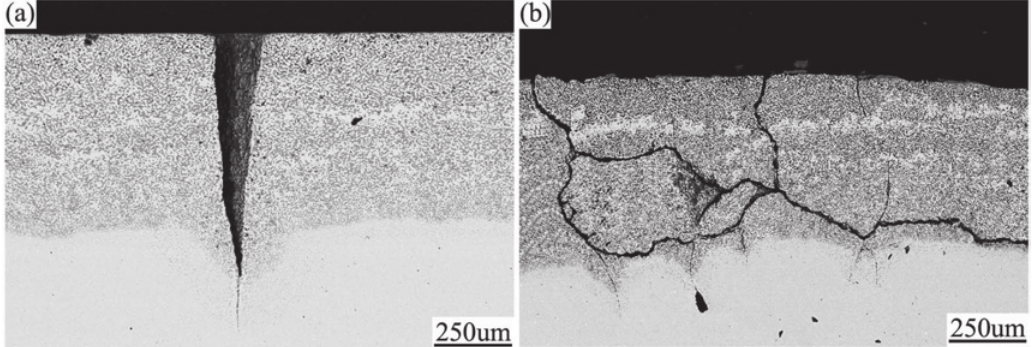
Fig. 14: SEM morphology of the longitudinal section: (a) the columnar grain; (b) the equiaxed